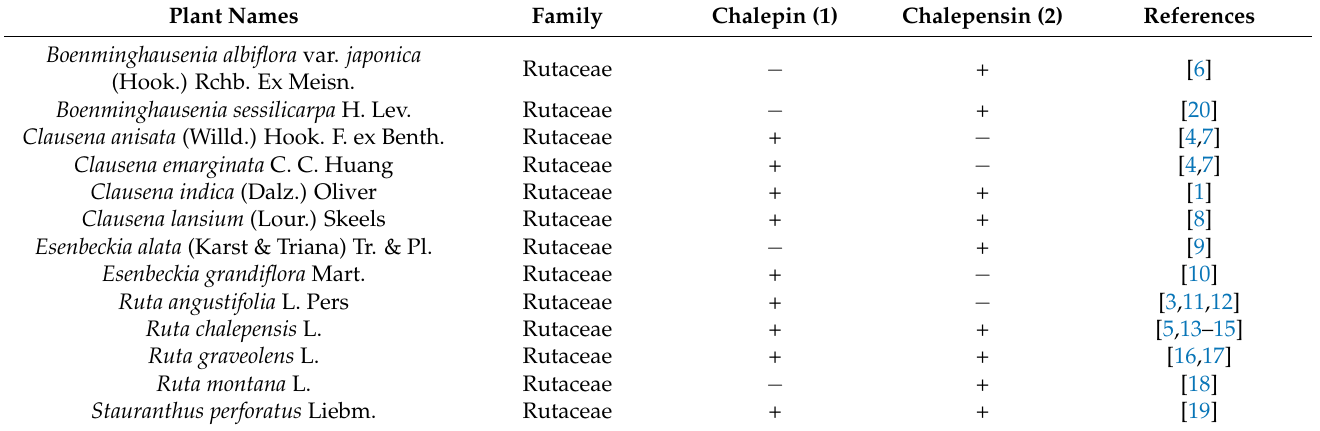
Table 1. Distribution of chalepin ( 1 ) and chalepensin ( 2 ) in the plant kingdom. Plant